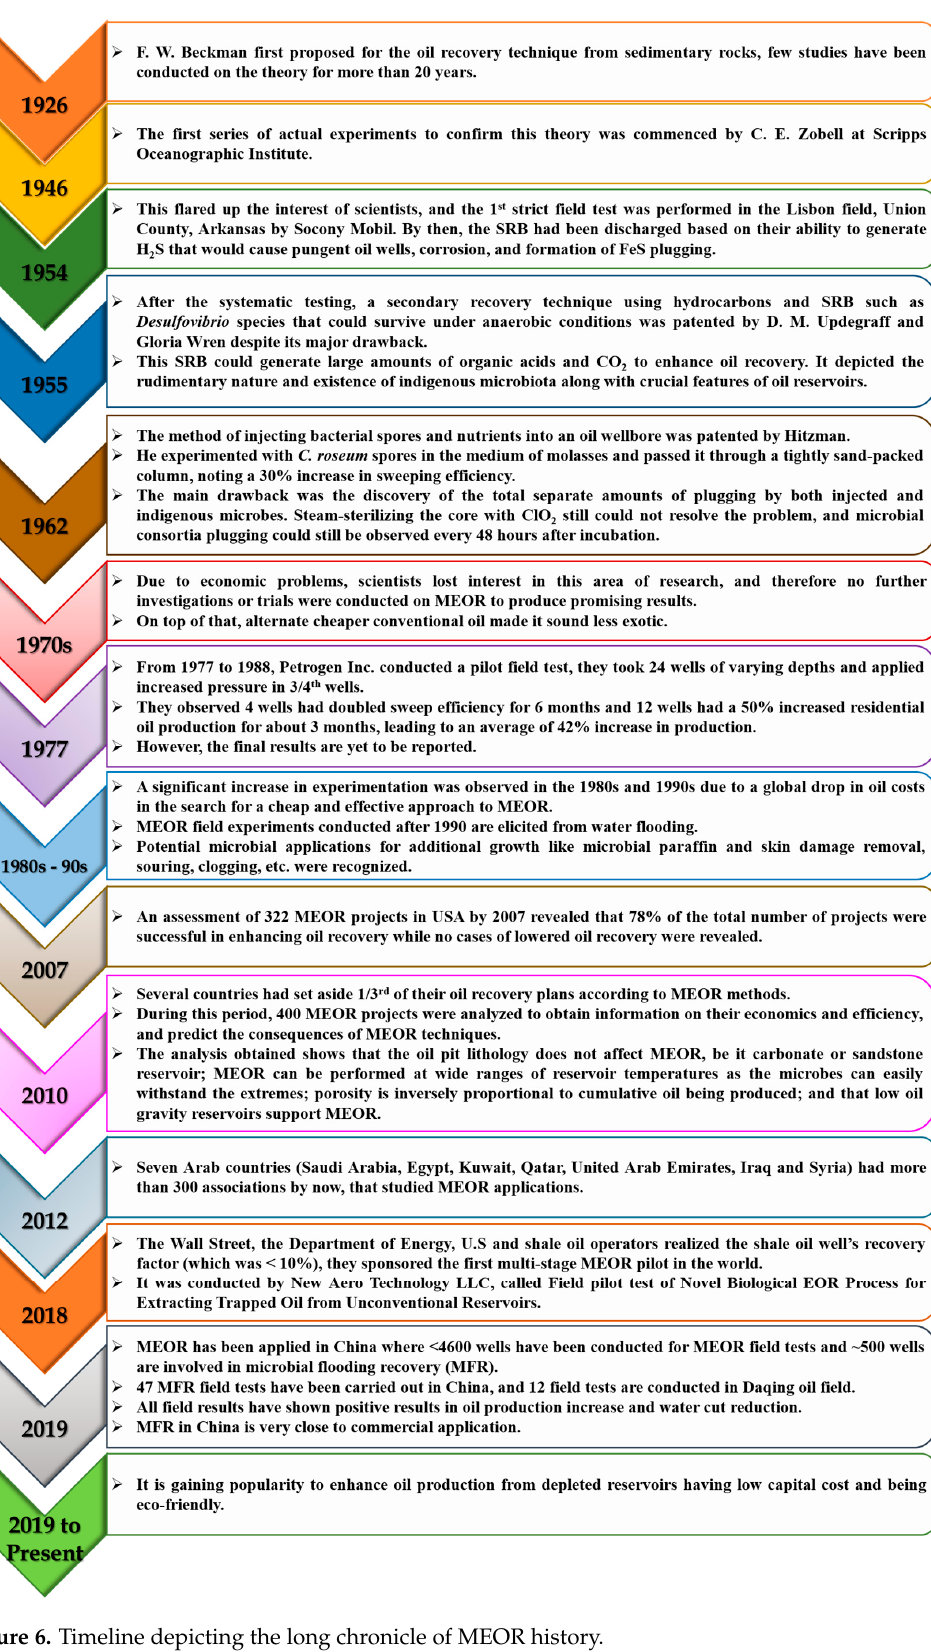
Figure 6. Timeline depicting the long chronicle of MEOR history.